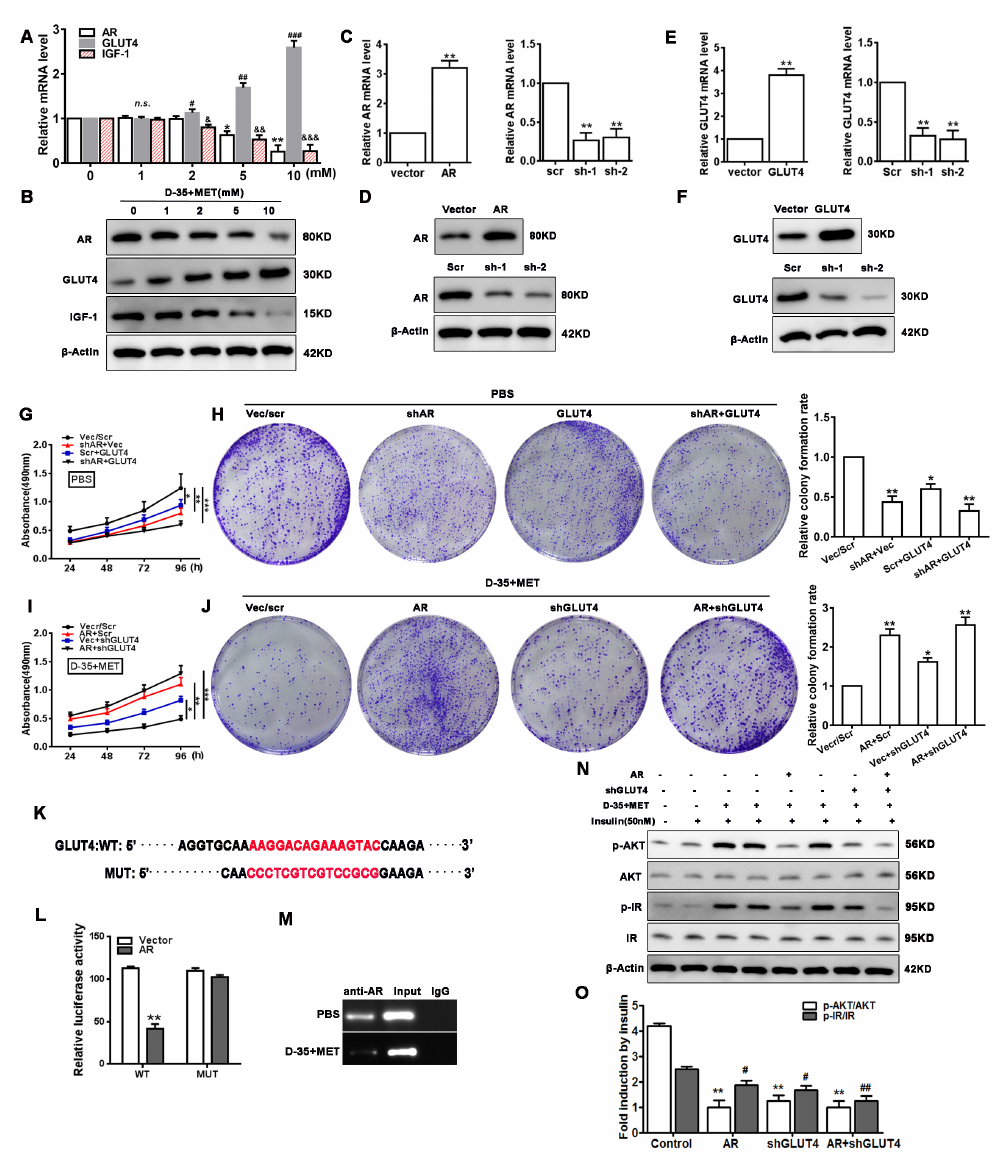
Figure 4. Cell proliferation and insulin resistance is regulated by Diane-35 and metformin. Ishikawa cells were treated with increasing concentrations of Diane-35 and metformin for 24 h (0, 1, 2, 5, and 10 mM). Then, the expression of AR, GLUT4, and IGF-1 was assessed by qRT-PCR ( A ) and Western blotting ( B ). qRT-PCR ( C , E ) and Western blot ( D , F ) analyses were done for transfection efficiency measurements of the GLUT4 and AR expression vectors in Ishikawa cells. CCK-8 and colony for- mation assays were performed in transfected cells treated with ( G , H ) or without ( I , J ) Diane-35 and metformin (10 mM). ( K ) Wild and mutant promoter sequences of the GLUT4 gene. ( L ) Dual-lucif- erase reporting experiment for AR. ( M ) ChIP assay for binding validation between the AR and GLUT4 promoters. ( N , O ) Under Diane-35 and metformin treatment, p-AKT, AKT, p-IR, and IR ex- pression levels in AR, and GLUT4-transfected Ishikawa cells with insulin stimulation. Data are